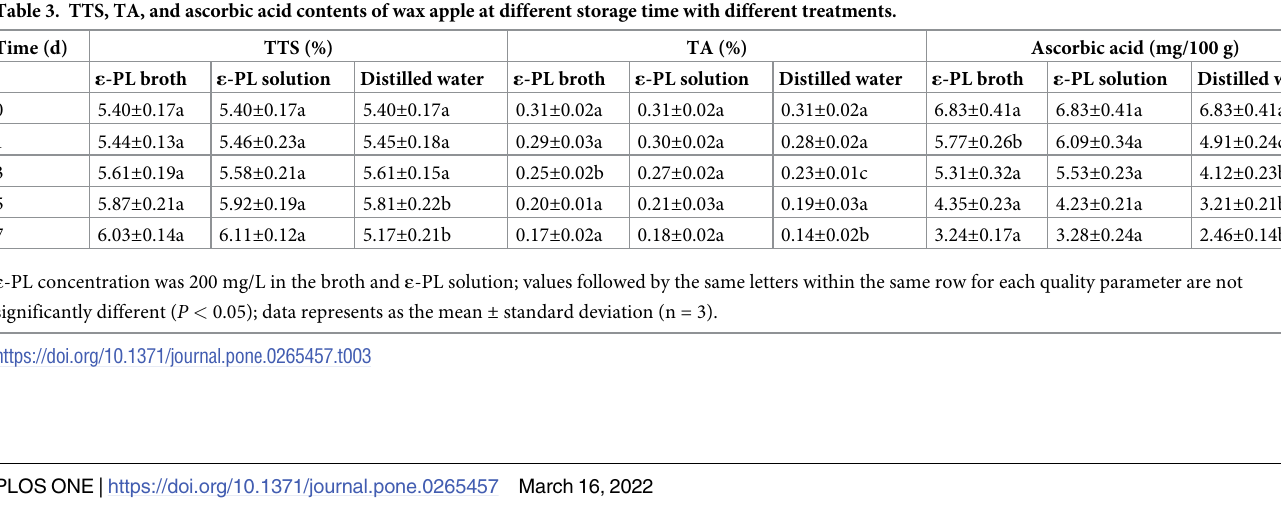
Table 3. TTS, TA, and ascorbic acid contents of wax apple at different storage time with different treatments. Time (d) TTS (%) TA (%) Ascorbic acid (mg/100 g) ε -PL broth ε -PL solution